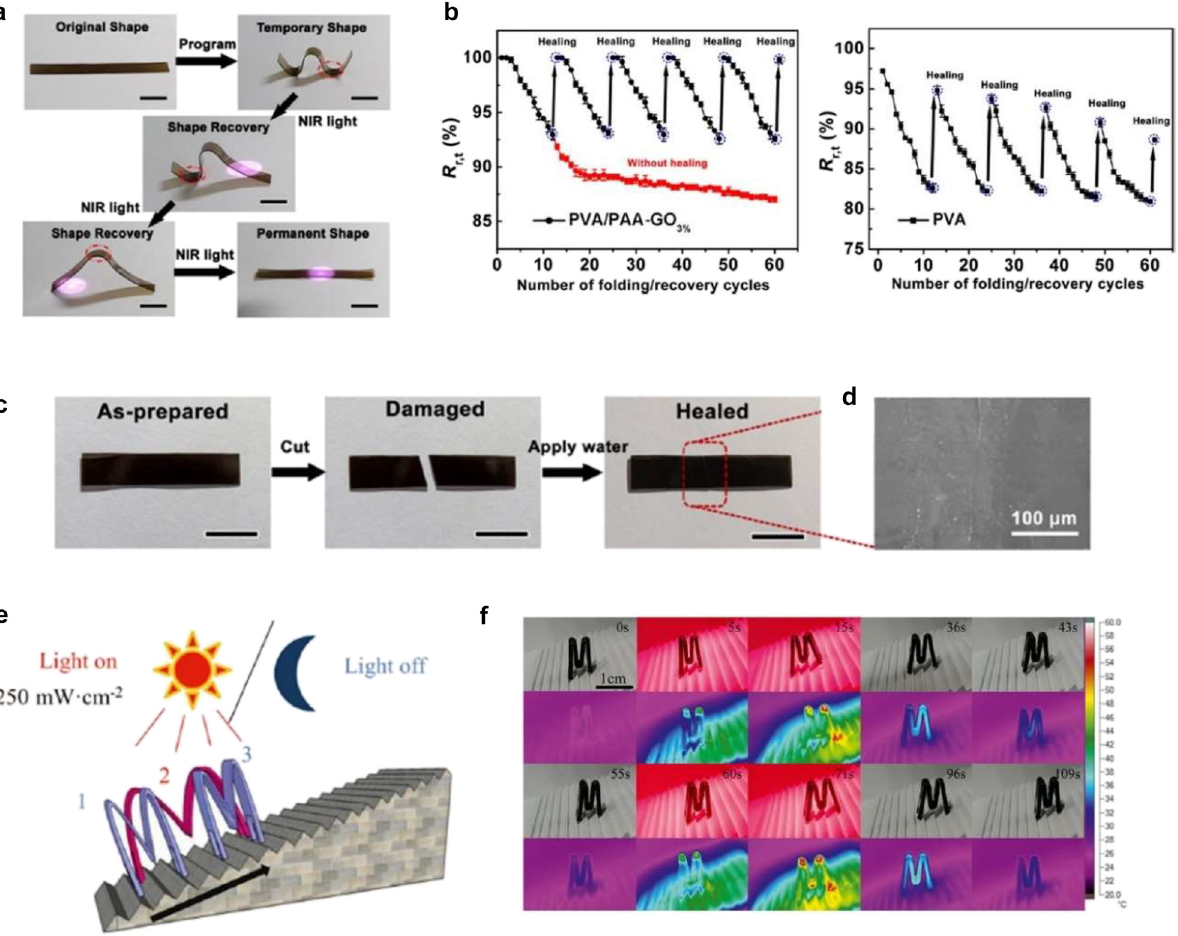
Figure 7: General photothermal method for light activation: carbon-based materials. Self-healableSMPstructuresactivatedbyNIRlight :(a)imagesofshapememoryprocessesunderNIRlightillumination.GOeffectivelyabsorbs NIR lightandproducesheat.(b) Recoveryratioof PVA/PAA-GO 3% with or withouthealing.(c) Imagesof the healingprocess.The fracturedpart iscompletelyrepairedbywater.(d)SEMimageofthehealed fi lm.AdaptedfromRef.[110].Copyright(2019)ACSPublications. Reversibleshape memory crawling robot : (e) schematic of the crawling robot locomotion under sequential light switching. (f) Optical and IR images of the crawling robot ascending stairs by sequential light switching. Adapted from Ref. [111]. Copyright (2019) ACS